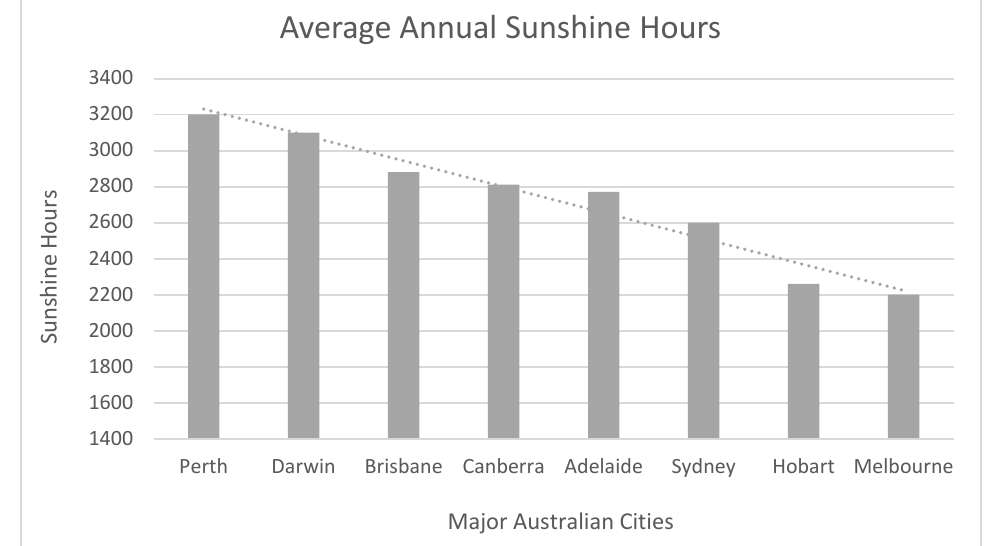
Figure 1. Average annual sunshine hours for major Australian cities (based on data from the Bureau of Meteorology, Australian Government).